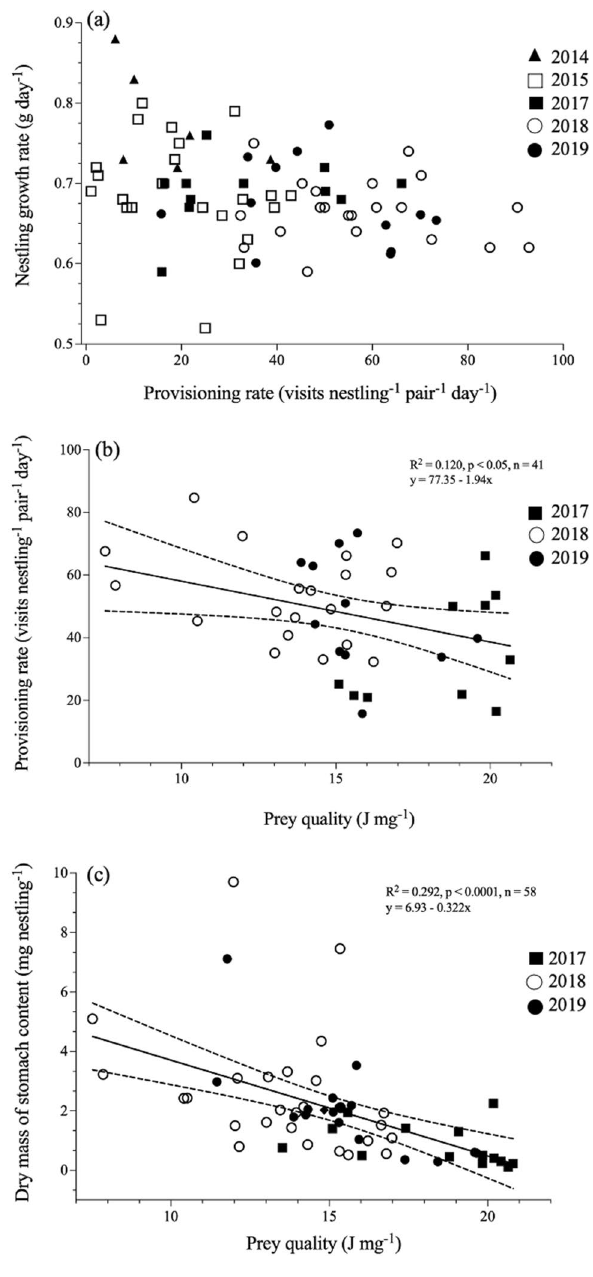
Figure 4. Linear regressions between provisioning rate and growth rate ( a , 73 broods, including 39 of black- capped chickadees and 34 of boreal chickadees), between prey quality and provisioning rate ( b , 41 broods, 24 of black-capped chickadees and 17 of boreal chickadees) and between prey quality and dry mass of stomach contents ( c , 58 broods, 36 of black-capped chickadees and 22 of boreal chickadees) in nestlings of black-capped and boreal chickadees sampled at the FER Macpès, Rimouski, Canada (data combined for both species, see text). Growth rate varied independently from provisioning rate, but birds provisioned more often when food was of lower quality. More food was also found in nestling stomachs when food was of lower quality. See text for full mixed model results including all the variables. The dotted lines show 95% confidence intervals for significant regression